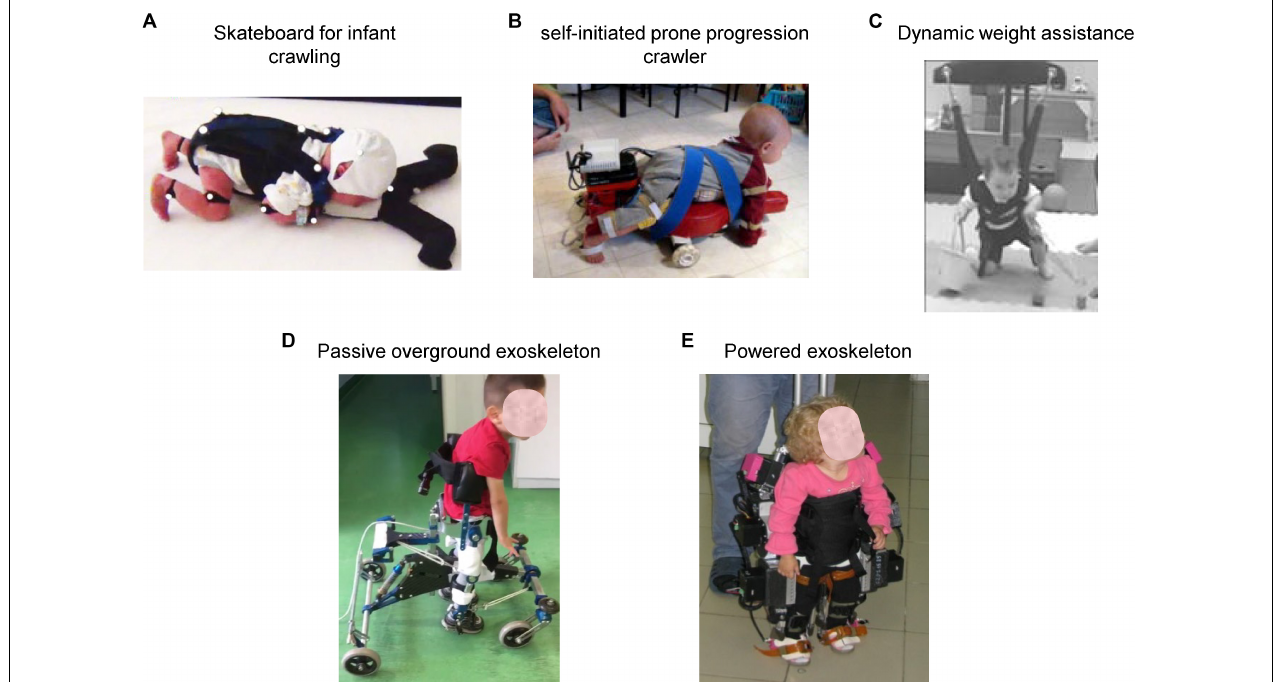
FIGURE 6 | Physical therapy interventions that may promote early locomotor movements and enhance stepping for infants at risk for locomotor delays. (A) Pediatric skateboard for entraining quadrupedal locomotion (crawling) in infants in early months of life [reproduced from Forma et al. (2019) with permission]. (B) Self-initiated prone progression crawler containing active components enabling the infant to push harder to produce the intended movement [reproduced from Kolobe and Fagg (2019) with permission]. (C) Dynamic weight assistance system allowing practice of motor skills that infants are not yet able to perform on their own (crawling, knee walking, walking, climbing, attempts to jump and falling) [reproduced from Prosser et al. (2012) with permission]. (D) Passive non-actuated exoskeleton (“Moonwalker” used to facilitate upright posture and stepping in young children with cerebral palsy (courtesy of Hilenia Catania). (E) Powered exoskeleton (“ExoAtlet Bambini”) for assisting stepping in children suffering from early neurological gait impairment (courtesy of Elena Pismennaya).